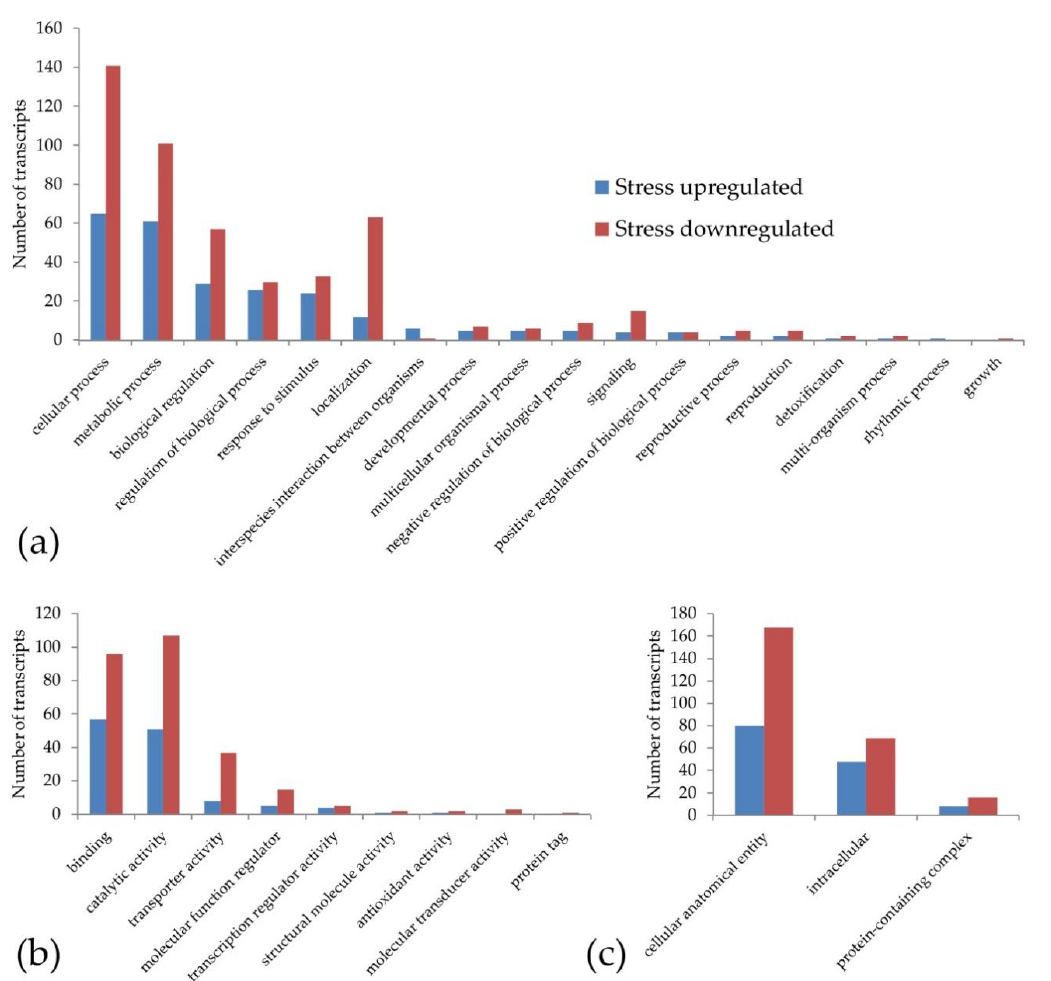
Figure 1. Classification of the weeping lovegrass differentially expressed transcripts according to gene ontology: ( a ) biological process ( b ) molecular function and ( c ) cellular component. Each main category was classified at level 2. Blue bars show the transcripts that are upregulated and red bars represent the transcripts that are downregulated under stress conditions.